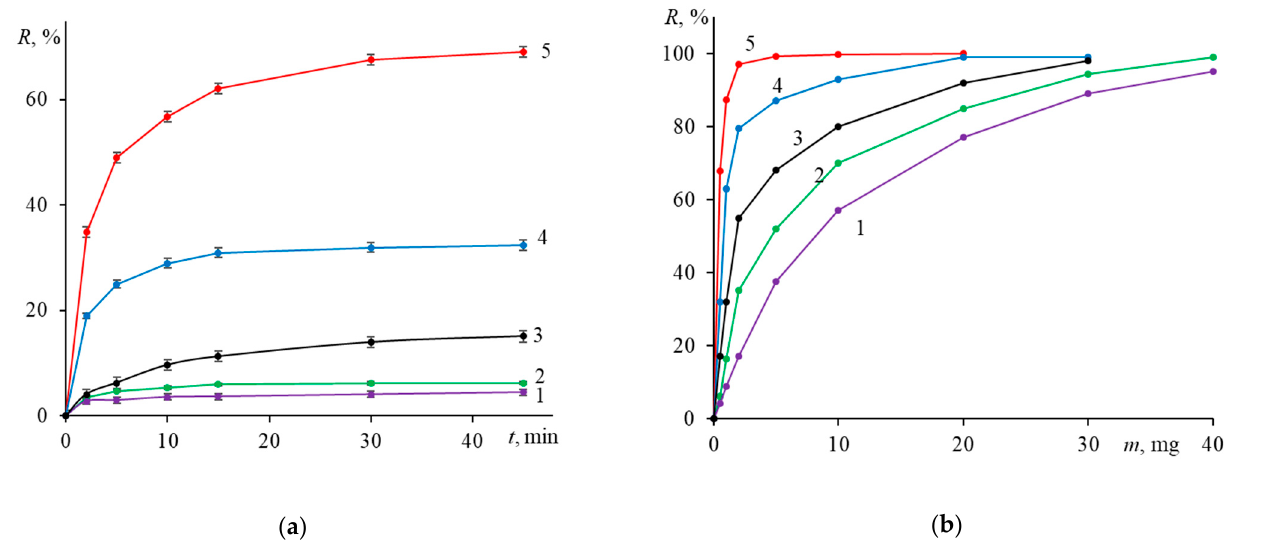
Figure 5. Time- and sorbent mass-dependent sorption of doxorubicin on various IONs. Conditions: ( a ) m 0 = m S = 0.5 mg and ( b ) m S = 0.5 mg; time 45 min, pH 7.4, 25 °C. Traces: (1)—Fe 3 O 4 , (2)— Fe 3 O 4 @Dex, (3)—Fe 3 O 4 @ С arb, (4)—Fe 3 O 4 @PSS, and (5)—Fe 3 O 4 @PEI. ( n = 3, p = 0.95).